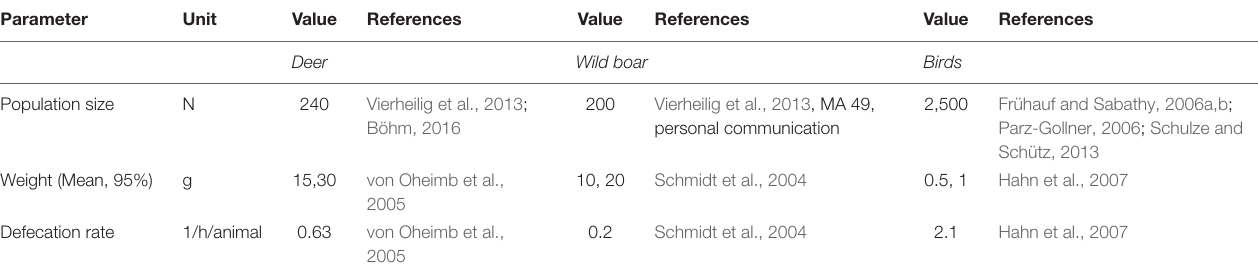
TABLE 2 | Input parameter settings for the animal sources in